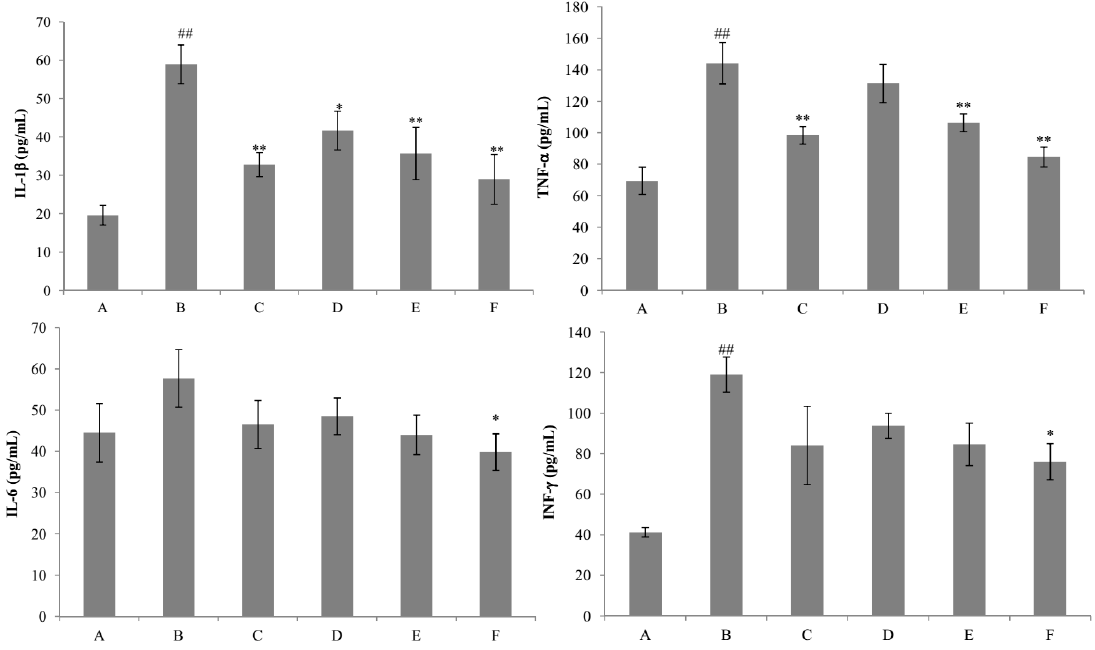
Figure 5. Effects of nicotiflorin on the serum interleukin-1 β (IL-1 β ), tumor necrosis factor- α (TNF- α ), interleukin-6 (IL-6), and interferon- γ (IFN- γ ) in Con A-intoxicated mice. (A) Control group; (B) Con A-treated group; (C) Con A and DDB (150 mg/kg bw)-treated group. (D) Con A and nicotiflorin (25 mg/kg bw)-treated group; (E) Con A and nicotiflorin (50 mg/kg bw)-treated groupl and (F) Con A and nicotiflorin (100 mg/kg bw)-treated group. Values are mean ± S.E.M., n = 10. ## p < 0.01 compared with the control group. * p < 0.05, ** p < 0.01 compared with the Con A group. Table 4. Effects of nicotiflorin on the pathological grading of D -GalN-intoxicated mice. Group 0 I II